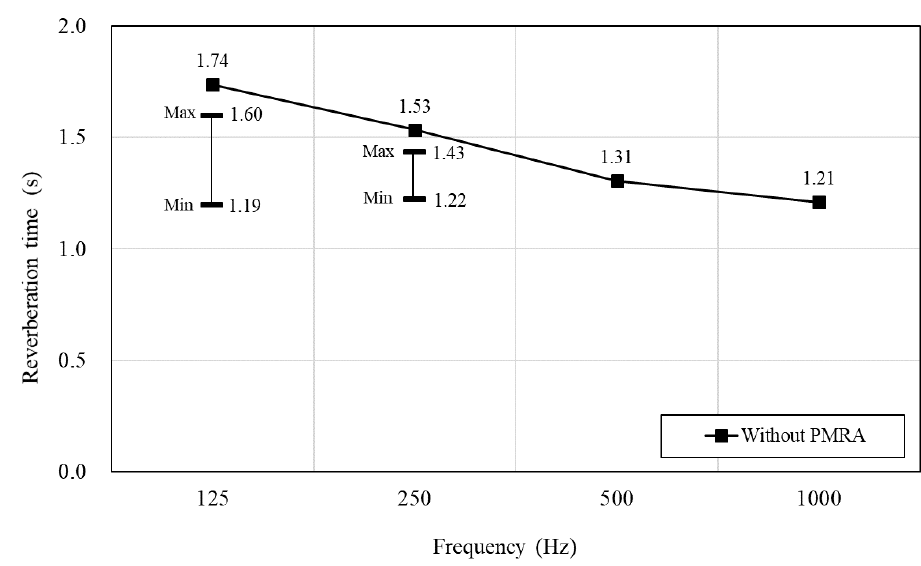
Figure 13. Sound source and measurement points.